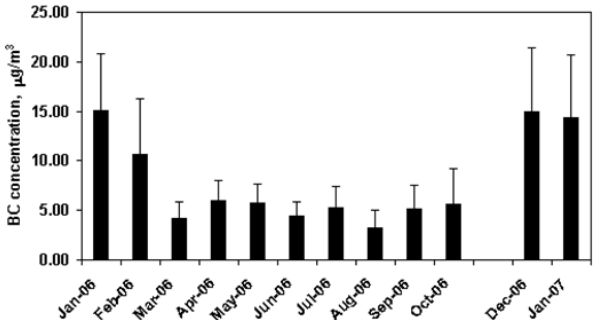
Fig. 4. Variation of monthly averages of Black Carbon (BC) concentration during daytime over Delhi during Jan 06 to Jan 07.